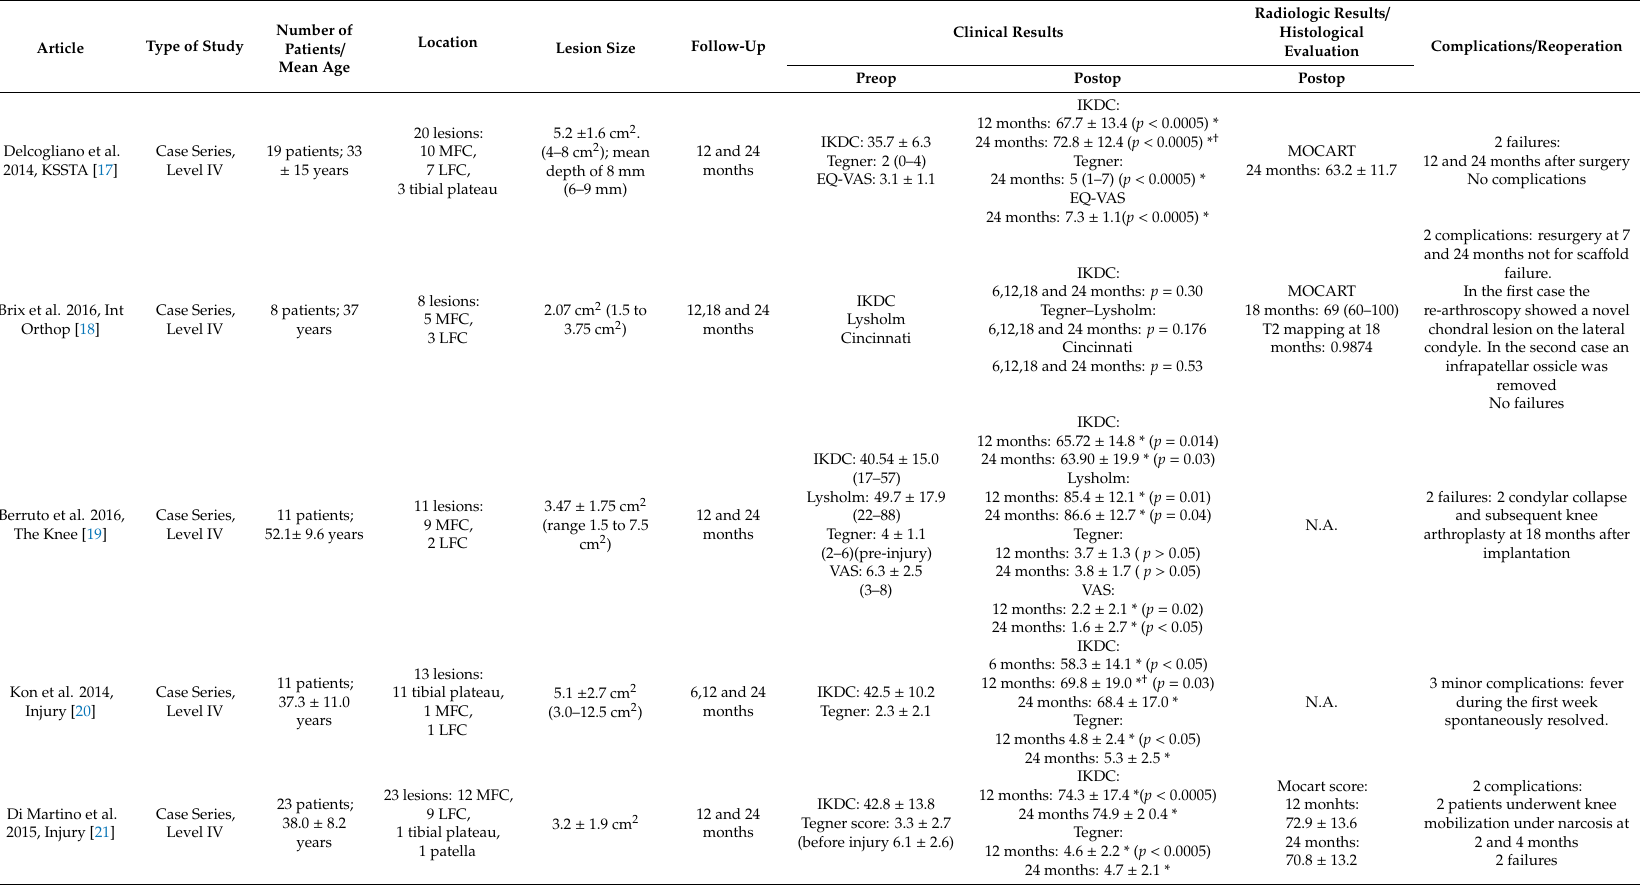
Table 1. Clinical studies investigating the use of MaioRegen for osteochondral knee